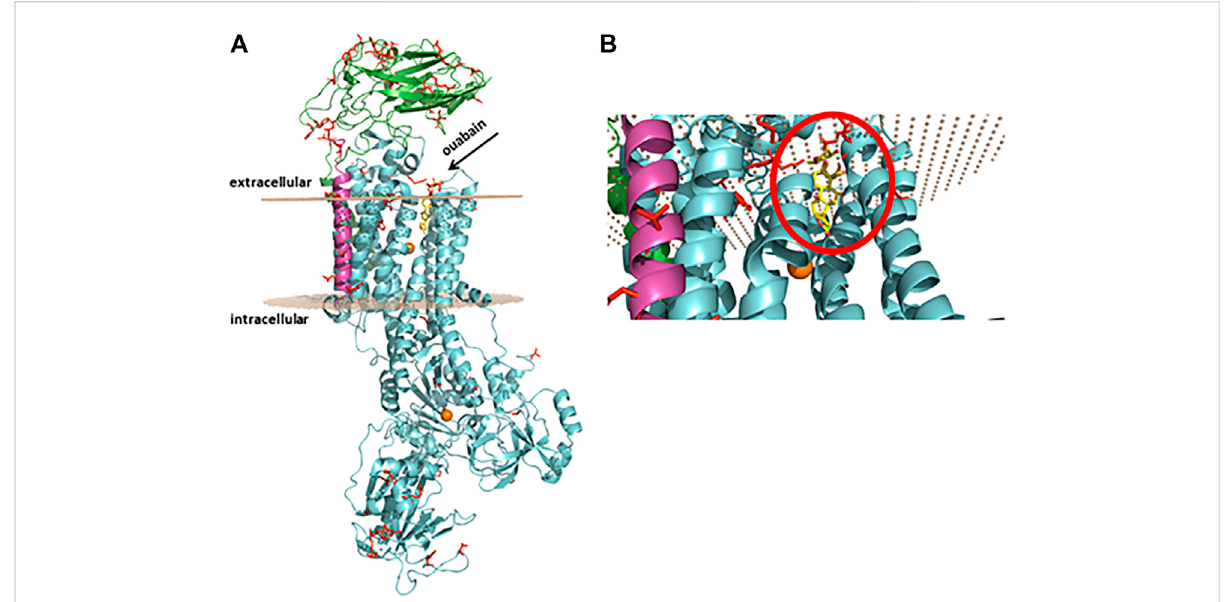
FIGURE 1 Protein representation of rat Na + /K + -ATPase α 1 β 1 γ isoform subunits. (A) In green, α 1 subunit, in cyan, β 1 subunit, and in pink, γ (FXYD2) subunit. The residues displaying the substitutions present in the rat compared to the human Na + /K + -ATPase protein. In orange, magnesium ions. The gray dots represent the Na + /K + -ATPase position at the plasma membrane, and the arrow points to the pocket where ouabain (in yellow) interacts. (B) Magni fi cation ofthe bindingpocket with ouabain (inside thered circle) seen from thebottom. The protein wasconstructedbyhomology using as reference the human crystallographic structure (pdb id:4RET) using the Swiss-model webserver, and for the representation the software PyMOL 7 was